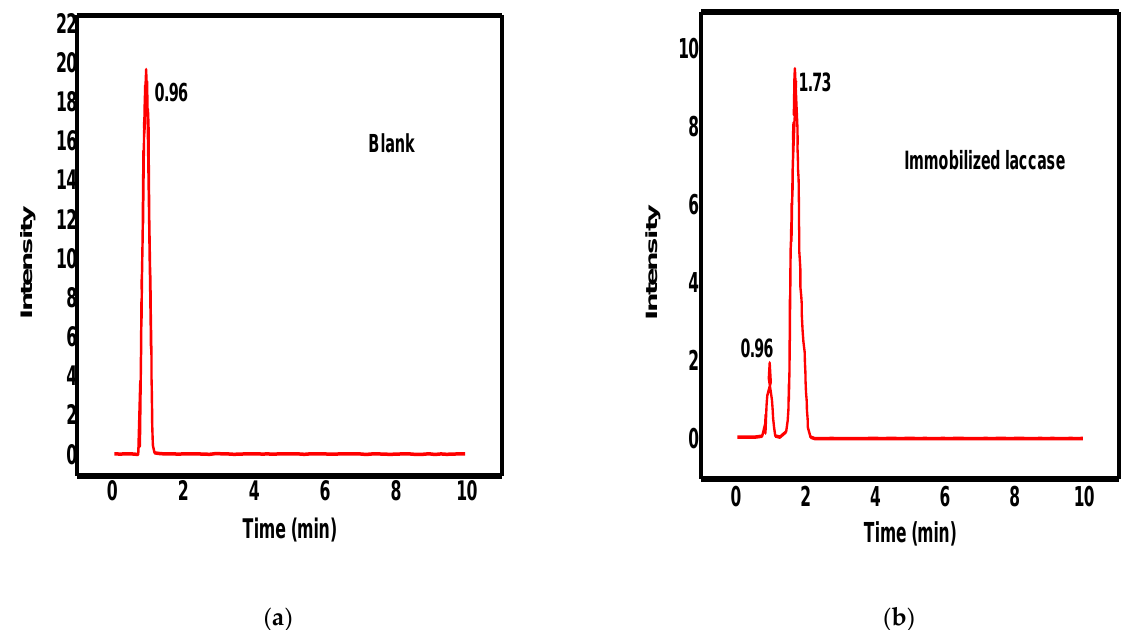
Figure 5. HPLC analysis of blank solution ( a ) and biodegraded DR23 dye solution using immobilized laccase ( b ).